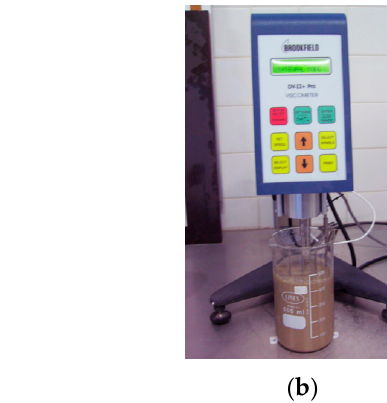
Figure 4. Viscometer: ( a ) Schematic diagram of a Brookfield-type viscometer; ( b ) Brookfield viscometer LV DV-II + PRO with spindle immersed in the sample.